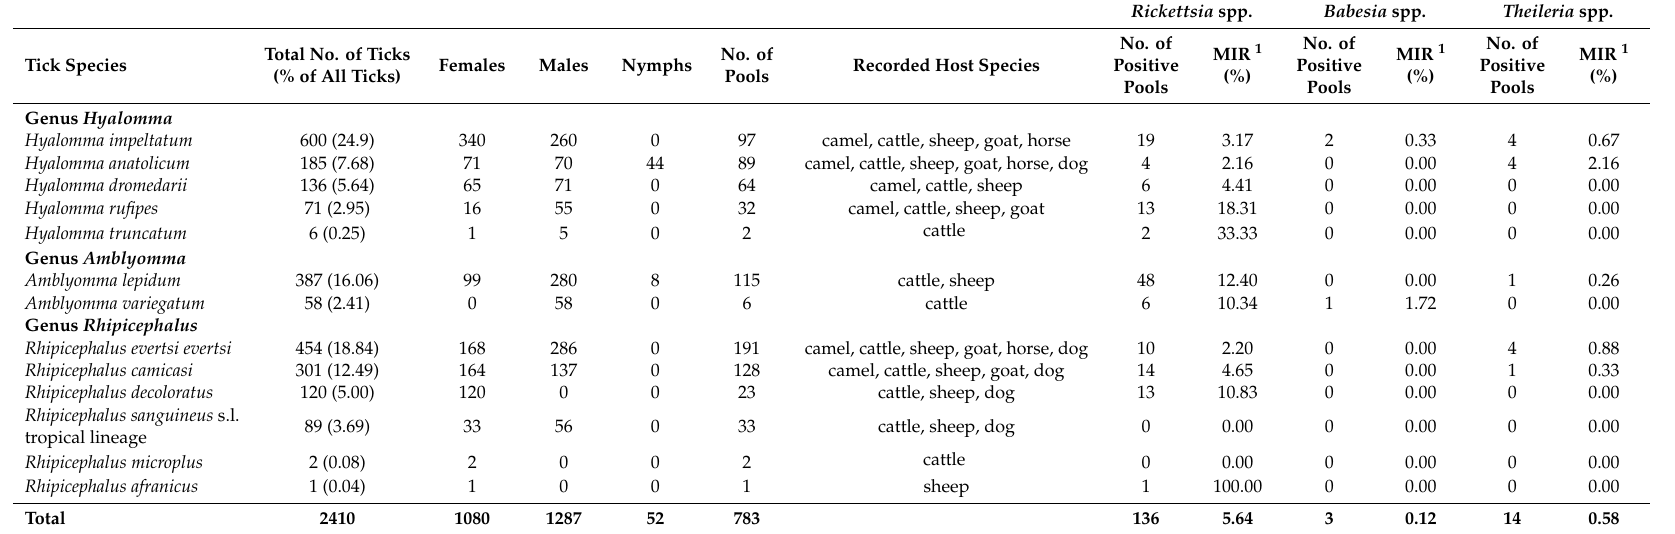
Table 1. Tick species collected from livestock and other domestic animals in Sudan and their pathogen infection